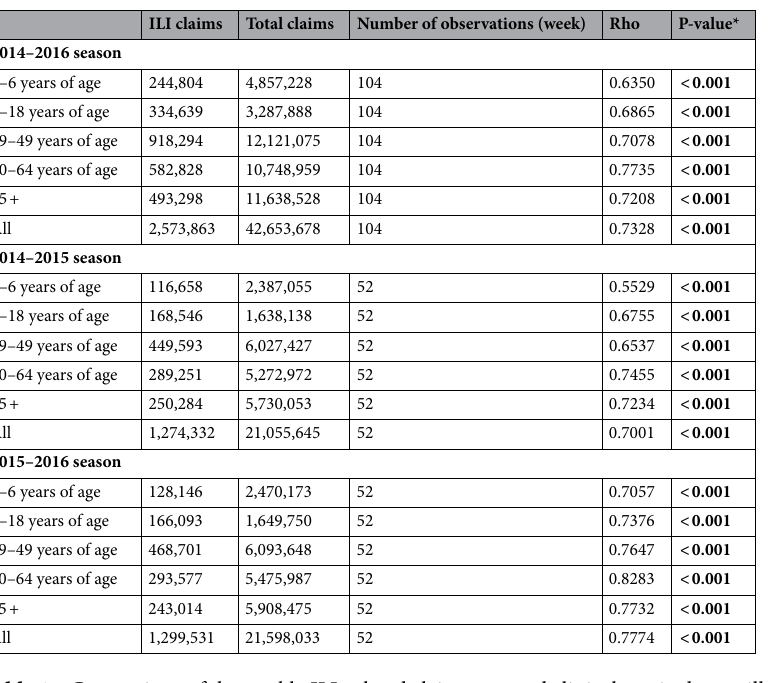
Table 1. Comparison of the weekly ILI-related claims rate and clinical sentinel surveillance report, 2014– 2016. Since HIRA’s age group has been provided differently from KCDC since 2017, only the 2014–2016 data set was used for analysis by age group. *P < 0.05 is considered statistically significant (indicated by bold